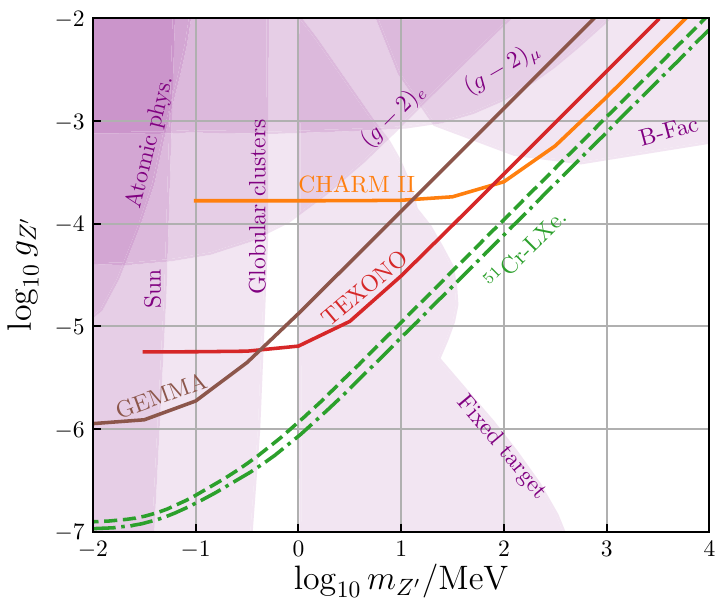
Figure 6 . Constraints on the gauge coupling of light Z . The constraints of TEXONO, CHARM (cid:31) II, and GEMMA are taken from ref. [34], other constraints are taken from refs. [49, 90]. The green dashed curve is for 51 Cr-LXe with configuration A, and dot-dashed for configuration C. Configuration B is not shown here for simplicity, which should be between the dashed and dot- dashed curves.